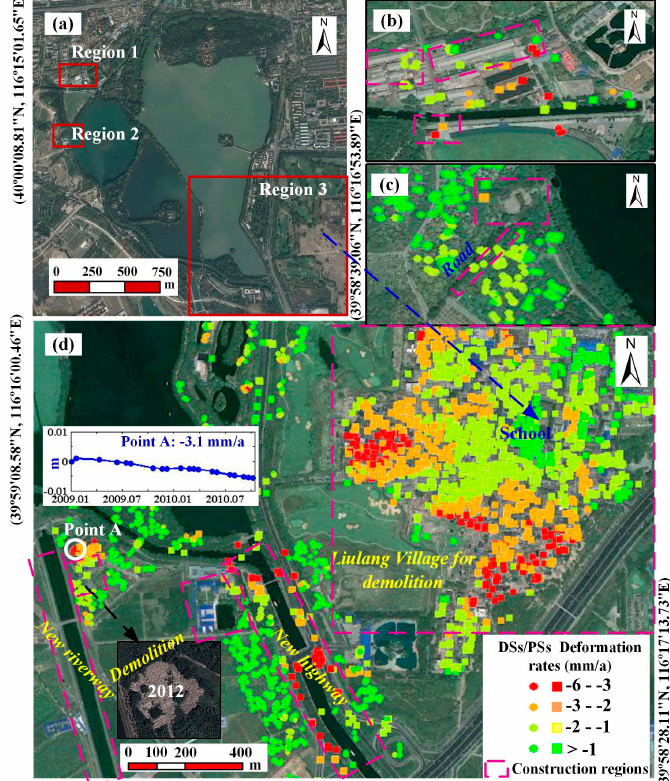
Figure 9. ( a ) Google Earth map of the subzone; ( b ) map of deformation rates in Region 1; ( c ) map of deformation rates in Region 2; and ( d ) map of deformation rates in Region 3. Displacement time series of Points A and B are also shown. Regions under construction are marked by pink dashed boxes.